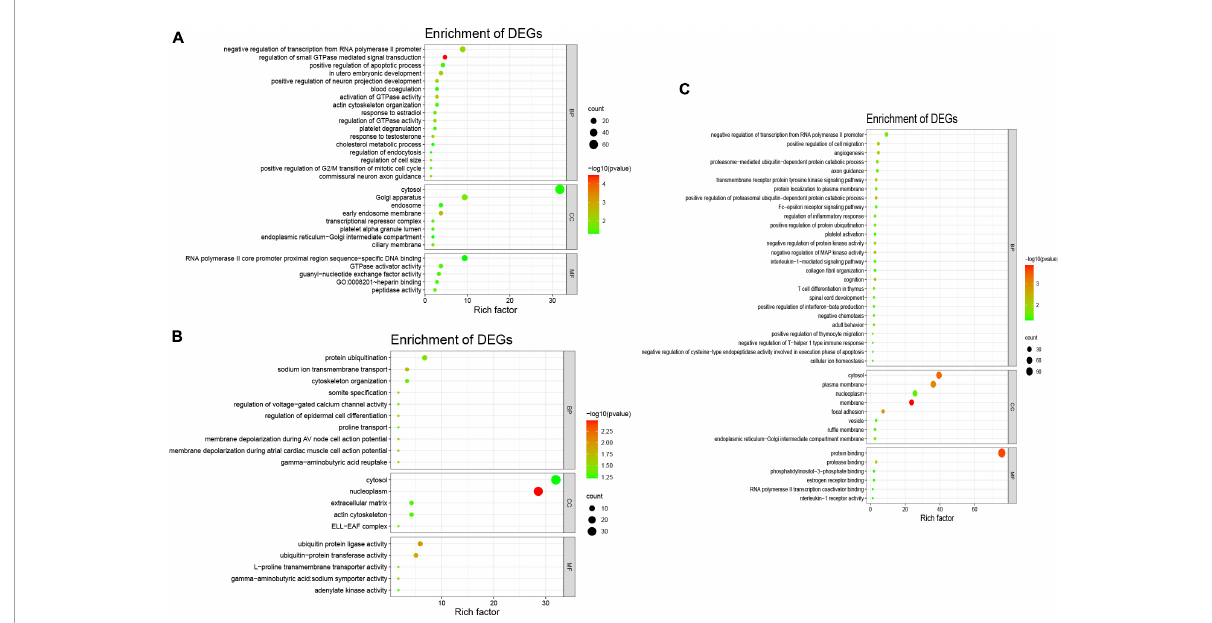
FIGURE3 Gene Ontology analysis of three differentially expressed tsRNAs. The GO analysis were composed of biological process (BP), cellular component (CC), and molecular function (MF). (A) tRF-59:76-Tyr-GTA-2-M3, the BP were consisted of protein ubiquitination, sodium ion transmembrane transport, cytoskeleton organization, regulation of voltage-gated calcium channel activity, regulation of epidermal cell differentiation, proline transport, membrane depolarization during AV node cell action potential, membrane depolarization during atrial cardiac muscle cell action potential; the CC were consisted of nucleoplasm, cytosol, extracellular matrix, actin cytoskeleton, ELL-EAF complex; and the MF were consisted of ubiquitin protein ligase activity, ubiquitin protein transferase activity, L-proline transmembrane transporter activity. (B) tRF-60:76-Val-AAC-1-M5, he BP were consisted of negative regulation of transcription from RNA polymerase II promoter, regulation of small GTPase mediated signal transduction, in utero embryonic development, positive regulation of neuron projection development, activation of GTPase activity, regulation of cell size; the CC were consisted of cytosol, Golgi apparatus, early endosome membrane, endosome; and the MF were consisted of RNA polymerase II core promoter proximal region sequence-specific DNA binding, GTPase activator activity, guanyl-nucleotide exchange factor activity, heparin binding, peptidase activity. (C) tRF-1:29-Gly-GCC-1, the BP were consisted of angiogenesis, positive regulation of cell migration, negative regulation of transcription from RNA polymerase II promoter, positive regulation of proteasomal ubiquitin-dependent protein catabolic process, negative regulation of MAP kinase activity; the CC were consisted of membrane, cytosol, plasma membrane, focal adhesion; and the MF were consisted of protein binding, protease binding, RNA polymerase II transcription coactivator binding, estrogen receptor binding.